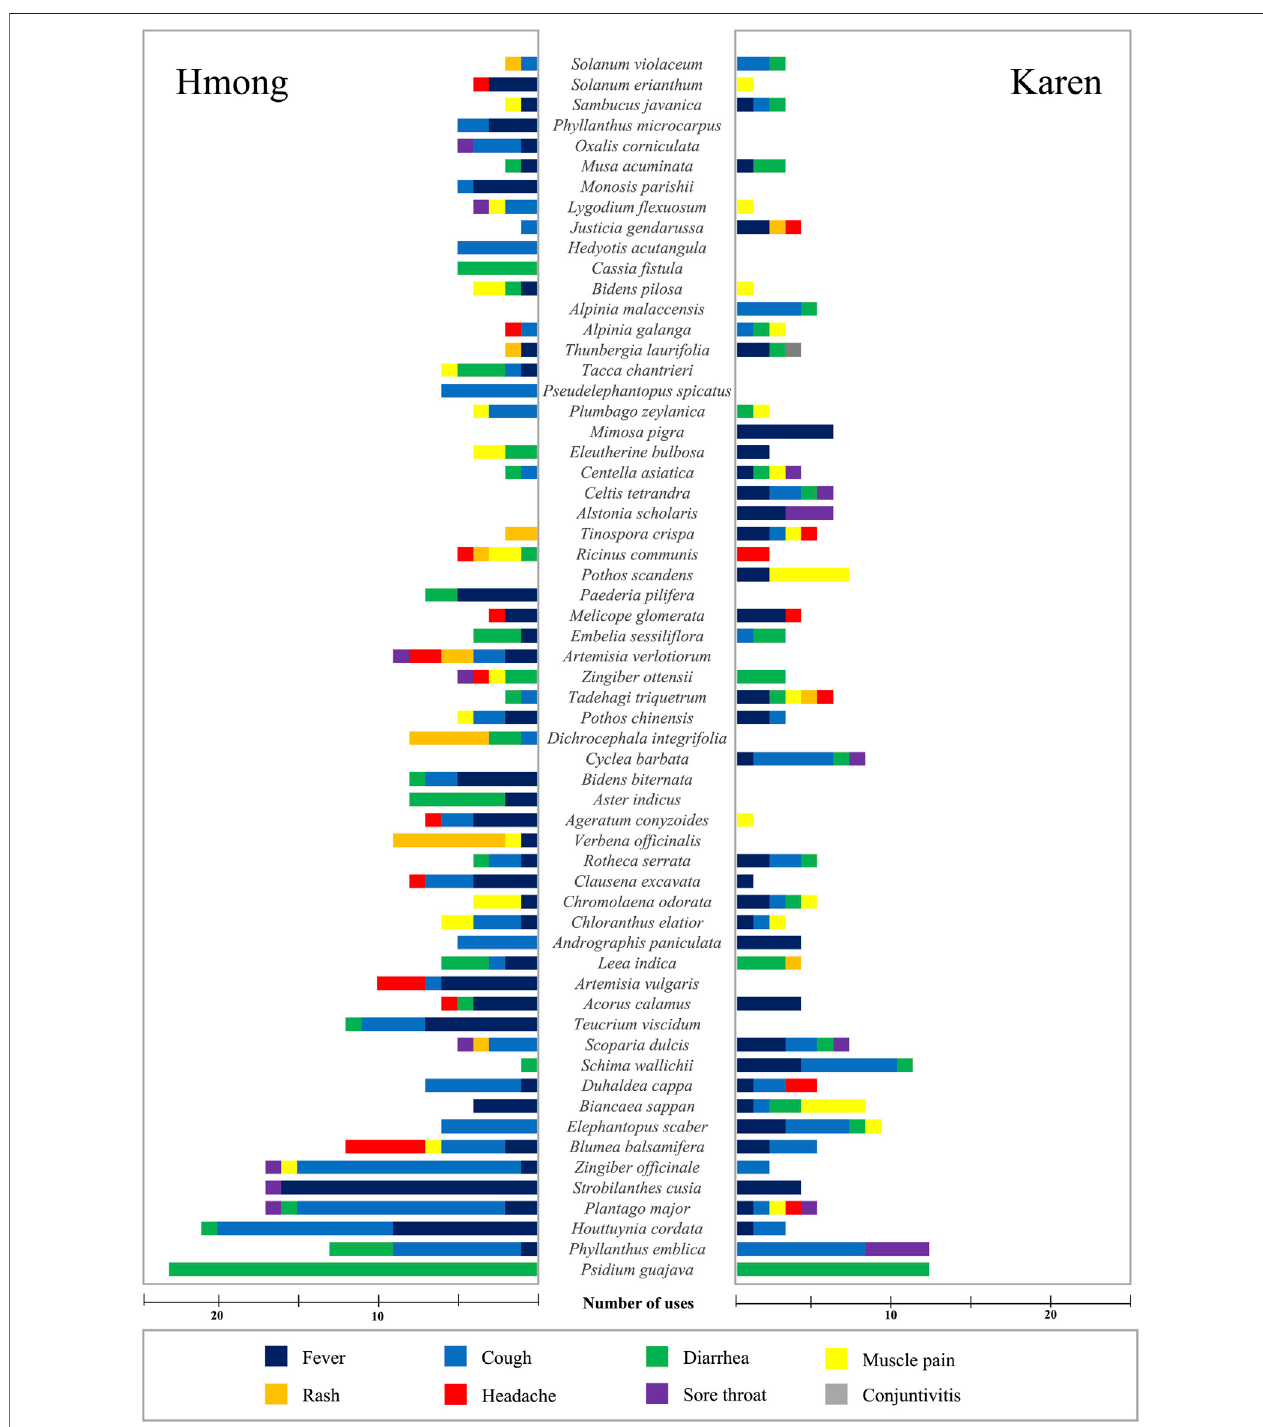
FIGURE3| Thenumbersofusereportsforthe60specieswhichhadhighUVsoftheHmongandtheKareninThailandfortreatmentsofeightmildCOVID-19symptoms. Bars in “ Hmong ” areas represent the number of each species ’ use reports by the Hmong while the bars in the “ Karen ” area represent the species use reports by the Karen.